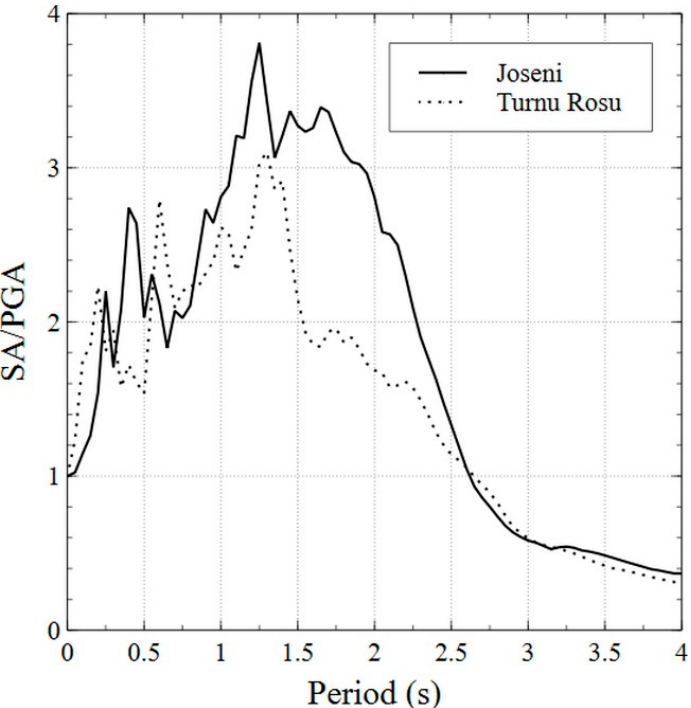
Figure 14. Comparison of the normalized GMRotD50 response spectra (SA/PGA) for the ground motions recorded at Joseni and Turnu Rosu during the Vrancea earthquake of November 2014.